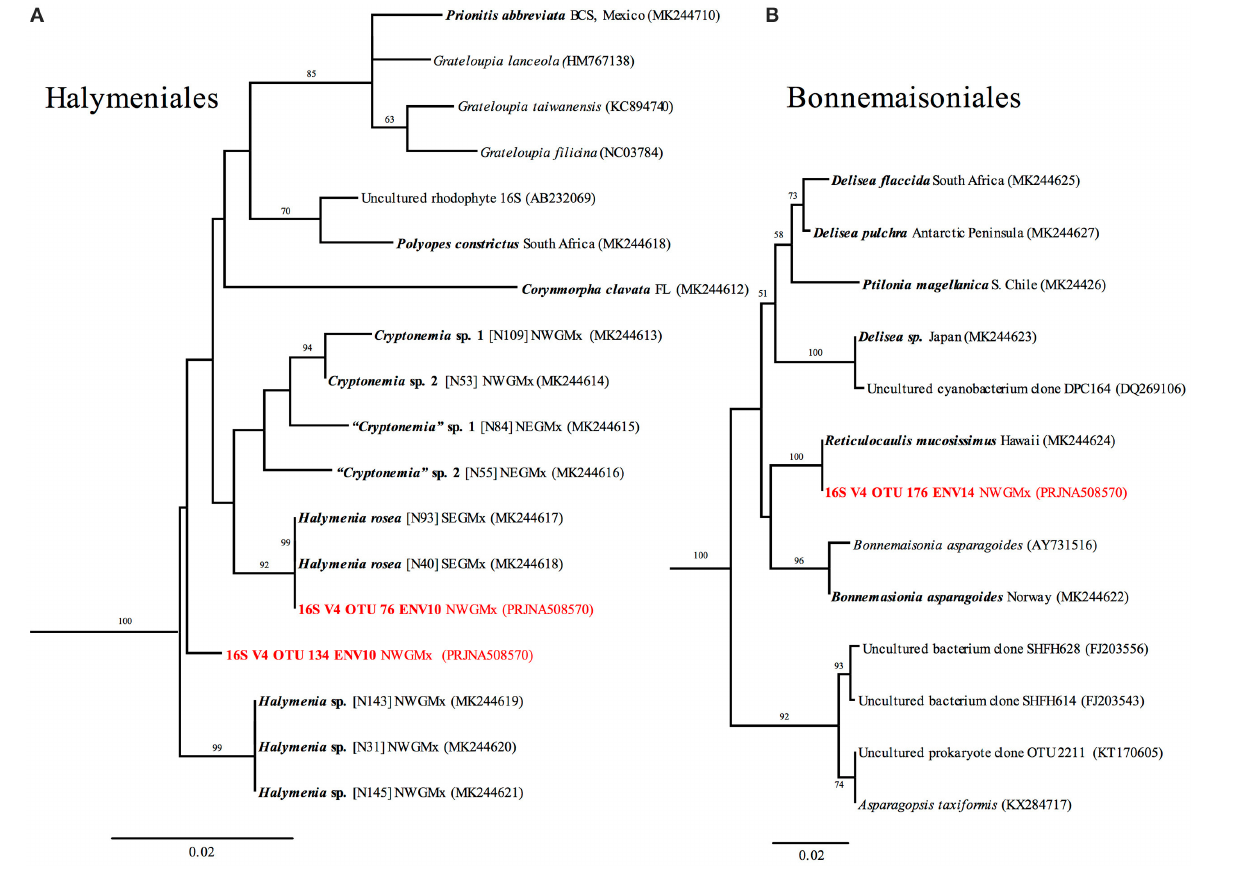
FIGURE 10 | RaxML trees of (A) Halymeniaceae and (B) Bonnemaisoniales based on 16S sequences, and 16S V4 metabarcodes (in red). Newly generated sequences are shown in bold. Branch numbers indicate bootstrap values > 50 out of 1,000